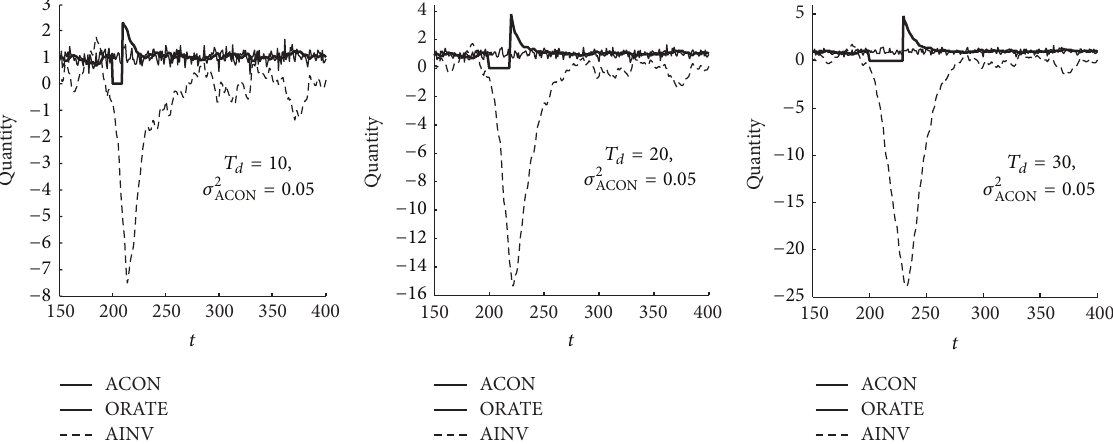
Figure 9: The change situations of ORATE and AINV for different values of 𝑇 𝑑 under random